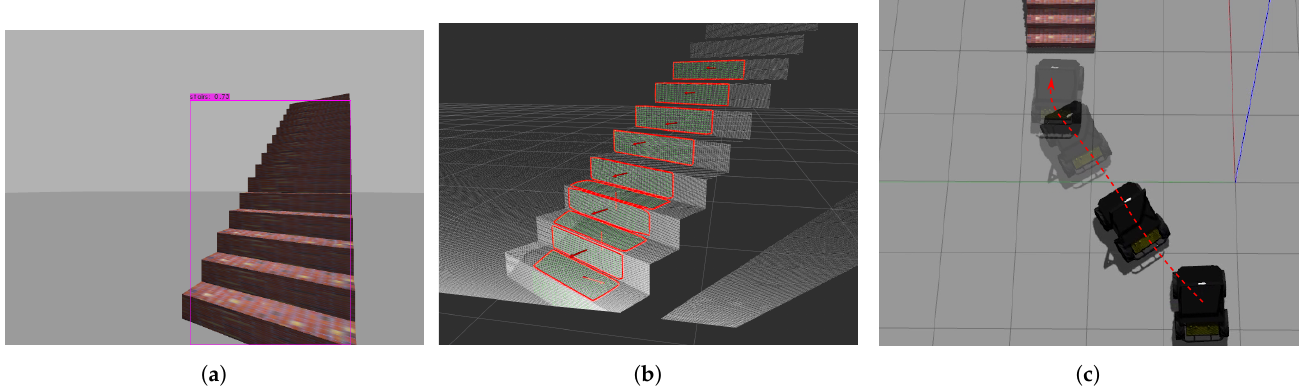
Figure 8. Pipeline test in simulation: ( a ) detection, ( b ) smooth region segmentation, ( c ) approach and alignment using Fuzzy controller.